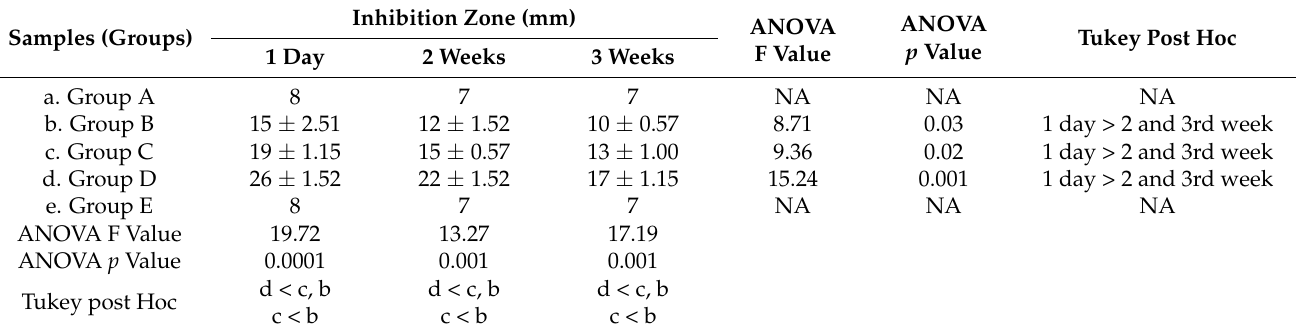
Table 4. Antimicrobial efficiency of biomaterial against S. mutans .